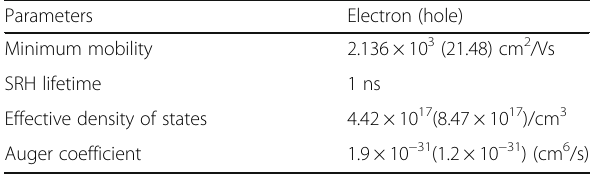
Table 1 Key material parameters